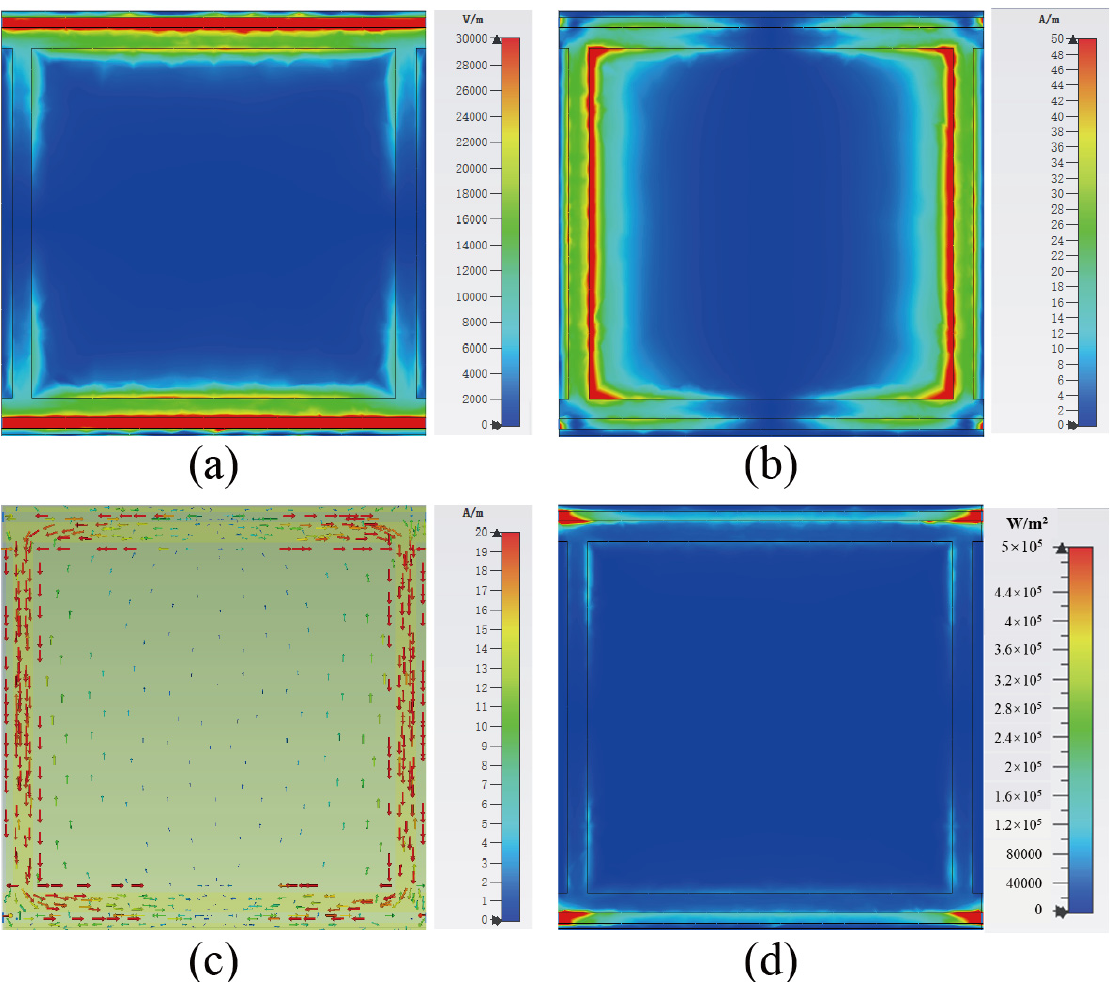
Figure 5. Simulations of ( a ) electric field magnitude, ( b ) magnetic field magnitude, ( c ) surface current distribution, and ( d ) power flow diagram distribution of the metasurface array unit cell at 2.4 GHz with incident plane wave irradiation along the − z -direction.